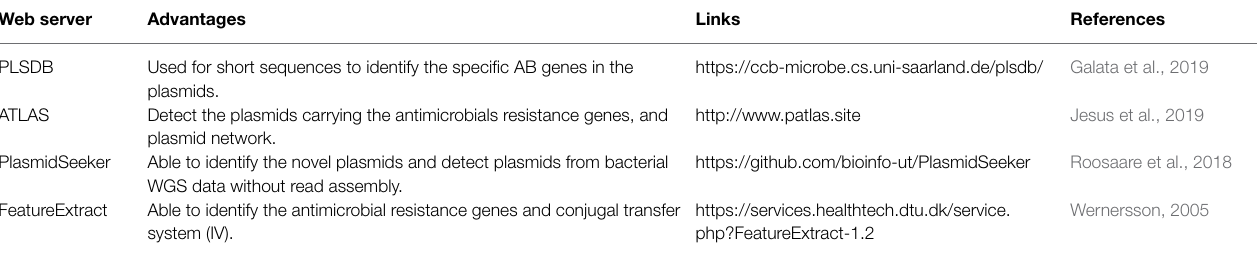
TABLE 2 | In silico analysis of resistance plasmid gene content and